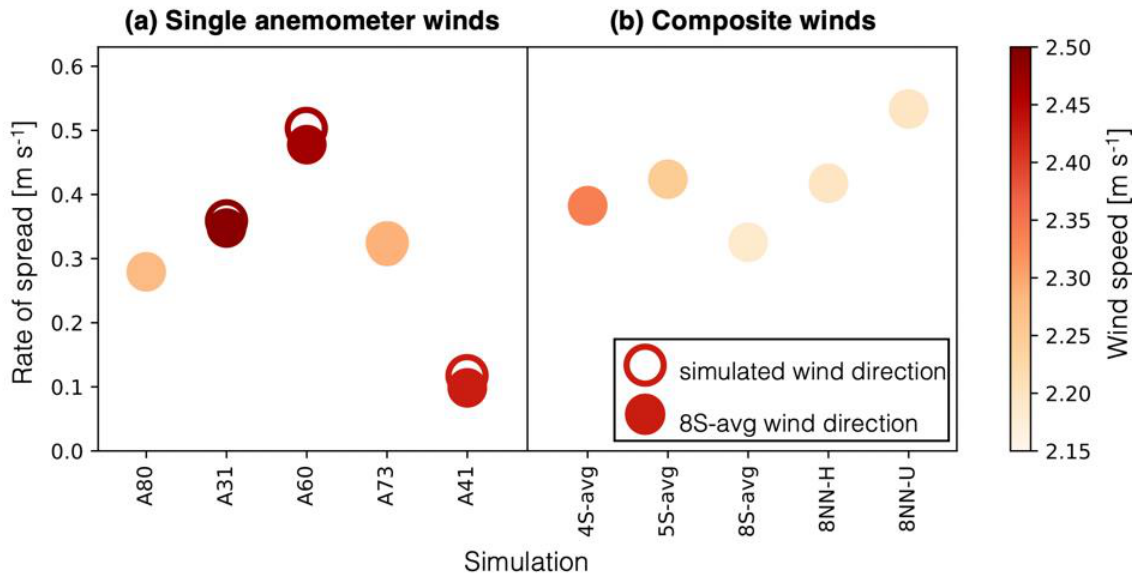
Figure 8. Spread rates for single anemometer ( a ) and composite wind ( b ) simulations plotted as a function of simulation specific (open circles) and eight-sensor average (filled circles) wind speed.